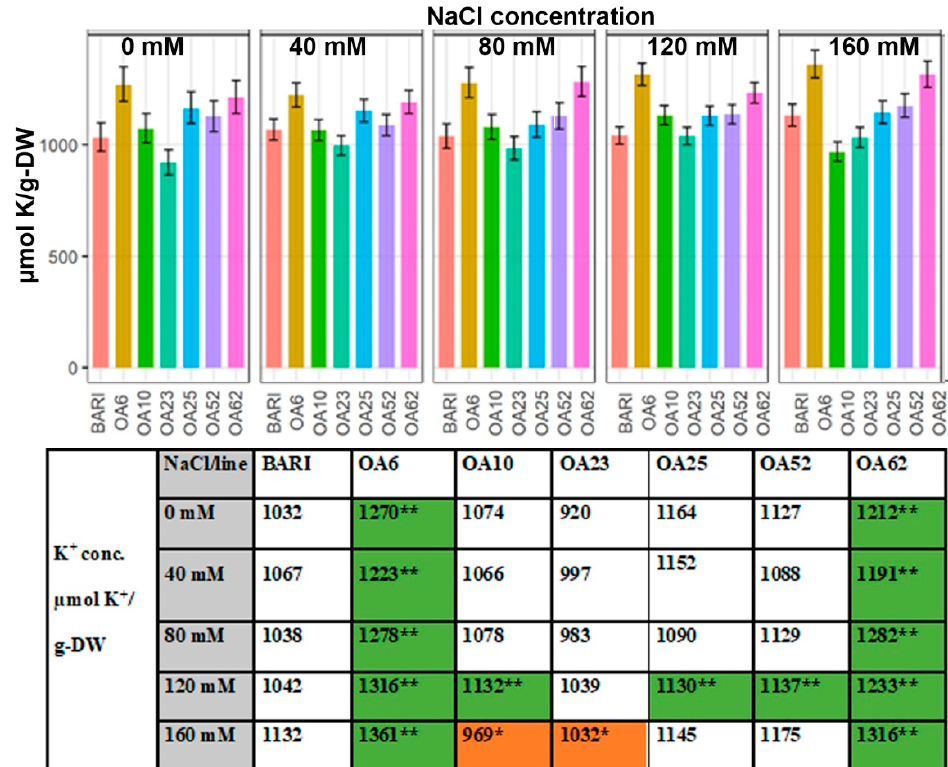
Figure 2. Dry weight (DW) concentration of K + at DAP 39–40. Data are shown for the control BARI Gom-25 (BARI) and mutagenized wheat lines OA6, OA10, OA23, OA25, OA52, and OA62 at DAP 39–40. NaCl concentrations applied were in the range from 0 mM to 160 mM. Upper panel: K + values with half-LSD error. Lower panel: table high-lighting the K + mean values with color codes for significantly higher (dark green **) or lower (orange *) values compared to BARI Gom-25, p ≤ 0.05.